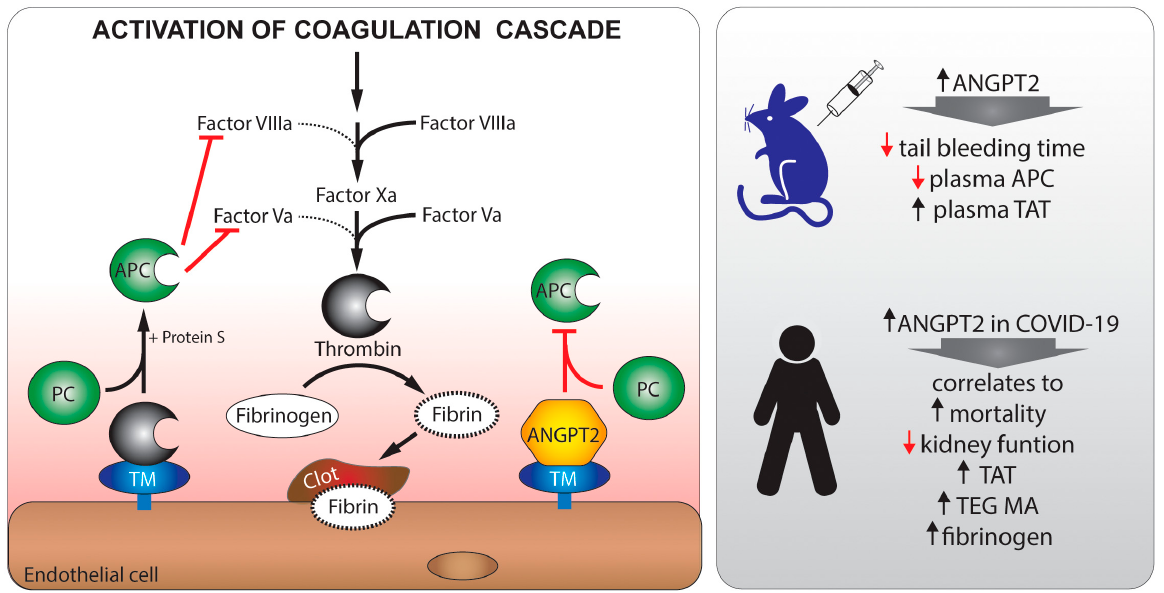
Figure 6. A schematic overview of ANGPT2 signaling in health and in hypercoagulation with high levels of ANGPT2 inhibiting TM-mediated anticoagulation. Thrombin/TM normally catalyzes protein C (PC) to activated protein C (APC), which inhibits Factor VIIIa and Factor Va. Increased levels of ANGPT2 in mice reduces tail bleeding time and plasma APC, while increasing TAT. In critically ill COVID-19 patients, ANGPT2 is increased and correlates to reduced kidney function, hypercoagulation, and mortality.